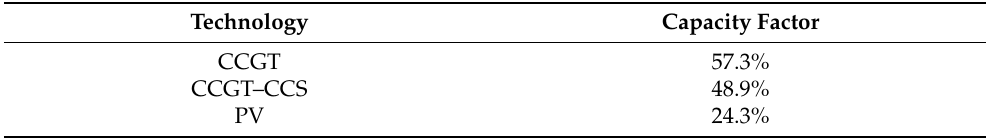
Table 5. Capacity factors per power generation